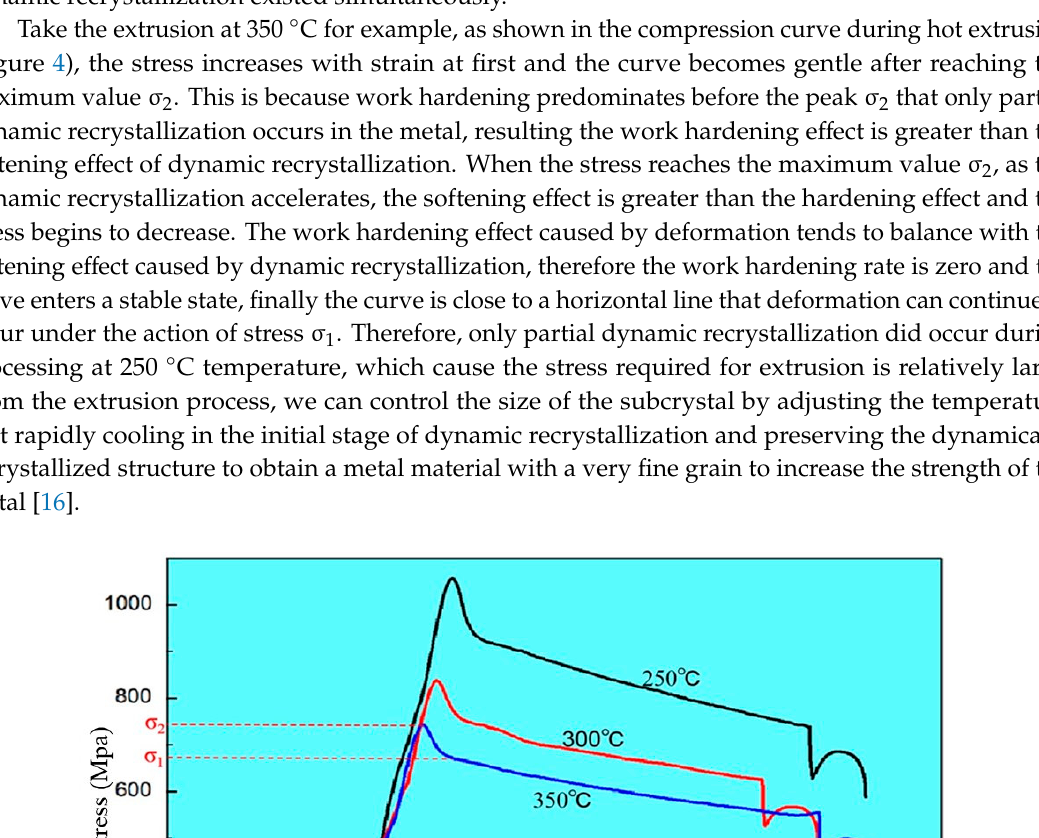
Figure 5. Schematic diagrams of extrusion. 3.4. Mechanical Properties On the whole, the mechanical properties of the alloy after extrusion have a significant improvement in strength and plasticity compared to the as ‐ cast alloy, which is mainly due to the large grain refinement after extrusion. Fine grain strengthening is an extremely important strengthening method for metal materials. It can not only improve the strength of materials but also improve ductility and toughness, which is unmatched by other strengthening methods [18]. The σ s , σ b , and elongation of the as ‐ cast Mg ‐ 2Y ‐ 1Zn ‐ 0.6Zr alloy were 135 MPa, 245 MPa, and 14.4%, respectively. The σ s , σ b , and elongation after extrusion could reach 322 MPa, 327 MPa, and 24.9%, respectively, but they were slightly different at different extrusion temperatures (Table 2). At an extrusion temperature of 250 °C, the alloy had a high yield strength and tensile strength while the ductility was relatively low, even lower than that of the as ‐ cast alloy. The main reasons for the poor plasticity of the alloy are as follows: (1) The dynamic recrystallization of the alloy was not fully performed, due to the low extrusion temperature; the work hardening during the plastic deformation process was not completely eliminated and a large number of high ‐ density dislocations still existed in the crystal grains, resulting in the resistance to dislocation motion during deformation